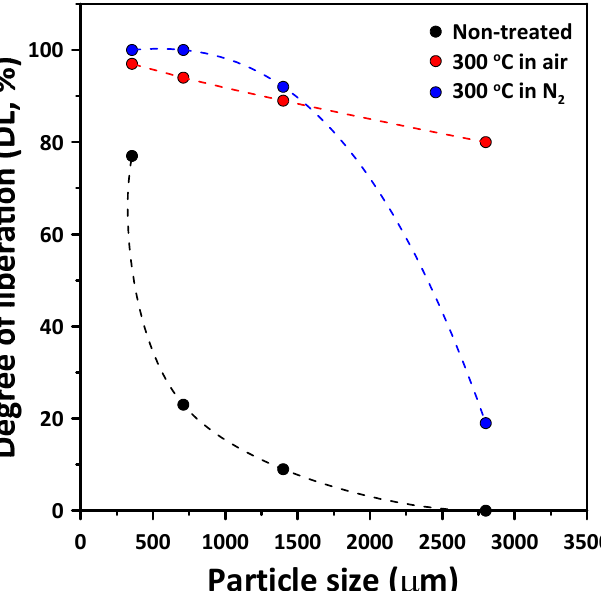
Figure 7. Degree of liberation (DL) of the thermally treated PCB particles at 300 °C in the various gas conditions (air and nitrogen).